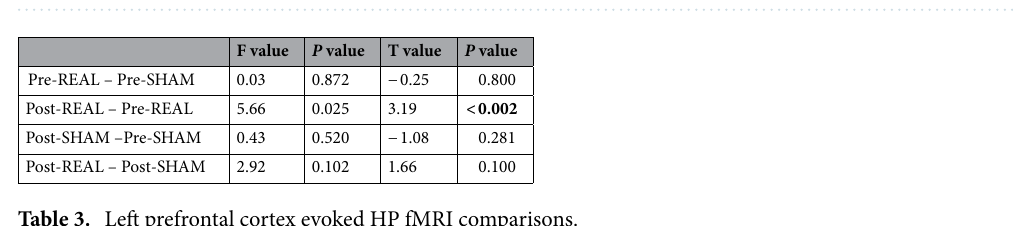
Figure 3. Sham treatment related resting state functional connectivity differences with LPFC as the seeded modulatory function region. Regions in brown–red indicated significant ( P < 0.01; Cluster size > 100 voxels) more functional connectivities to the LPFC in the Post-SHAM group in comparison to Pre-SHAM group, whereas regions in blue represented significant ( P < 0.01; Cluster size > 100 voxels) less functional connectivities to the LPFC in the Post-SHAM group in comparison to Pre-SHAM group. Glass brains were created using BrainVoyager QX 2.8.